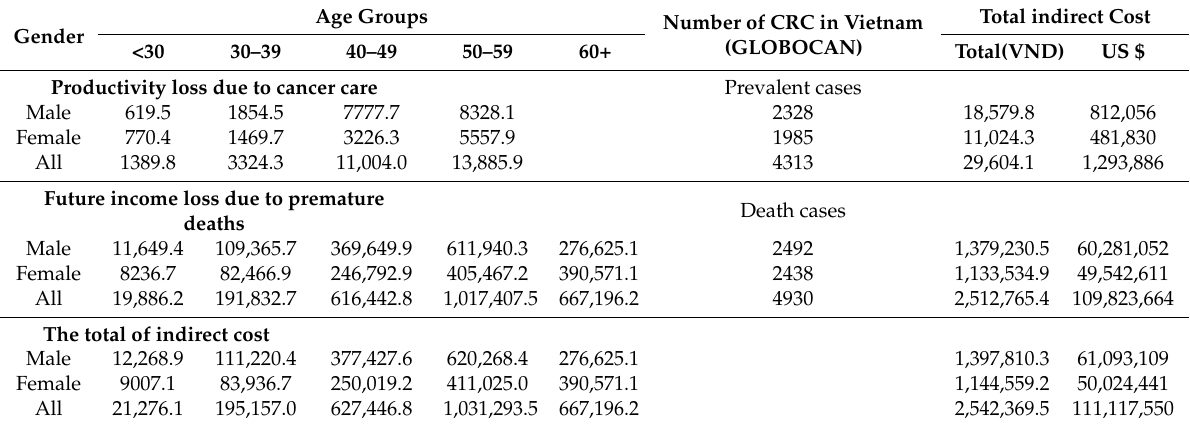
Table 3. Estimated Total Indirect Cost for CRC at National Level in Vietnam, 2018 (VND